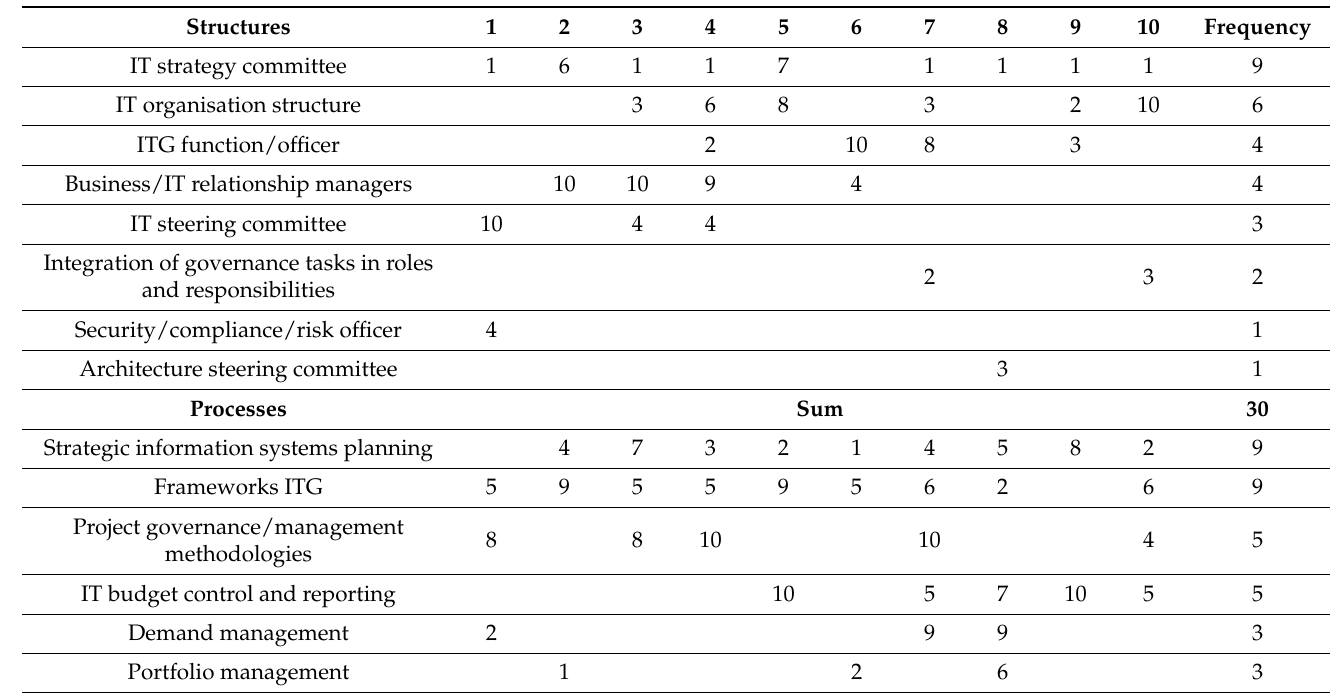
Table 3. Ten most important practices for each